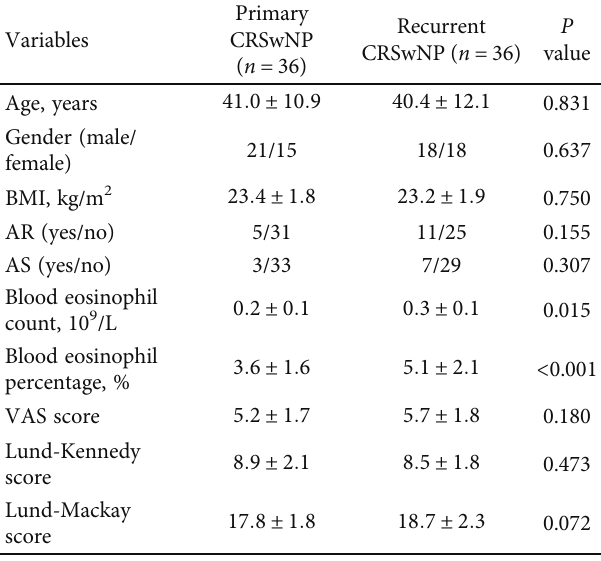
Table 2: The comparisons of cytokine levels between two